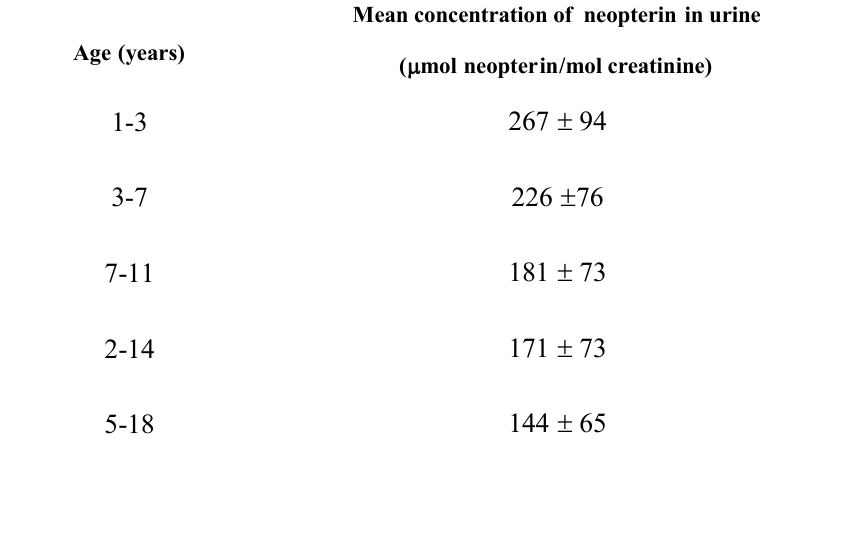
Table 2. Reference values of urine concentration of neopterin in children (adapted from: Reibnegger G, et al.: Urinary neopterin in malignant diseases of childhood - A marker for activity of the cell-mediated immunity. Tumor Diagn Ther